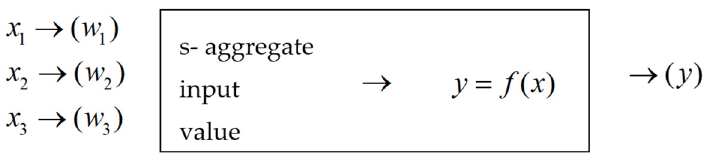
Figure 2. Schematic of the artificial neural network model, reflecting the processes occurring inside the neuron.